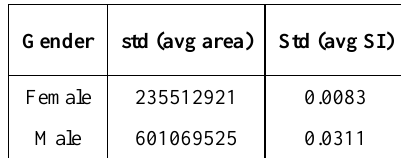
Table 4. Effect of weekdays on the activity space of men and